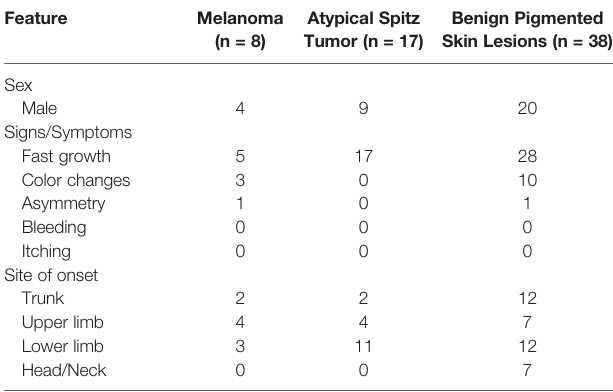
TABLE 1 | Clinical and demographic characteristics of the pediatric cohort according to lesion type.